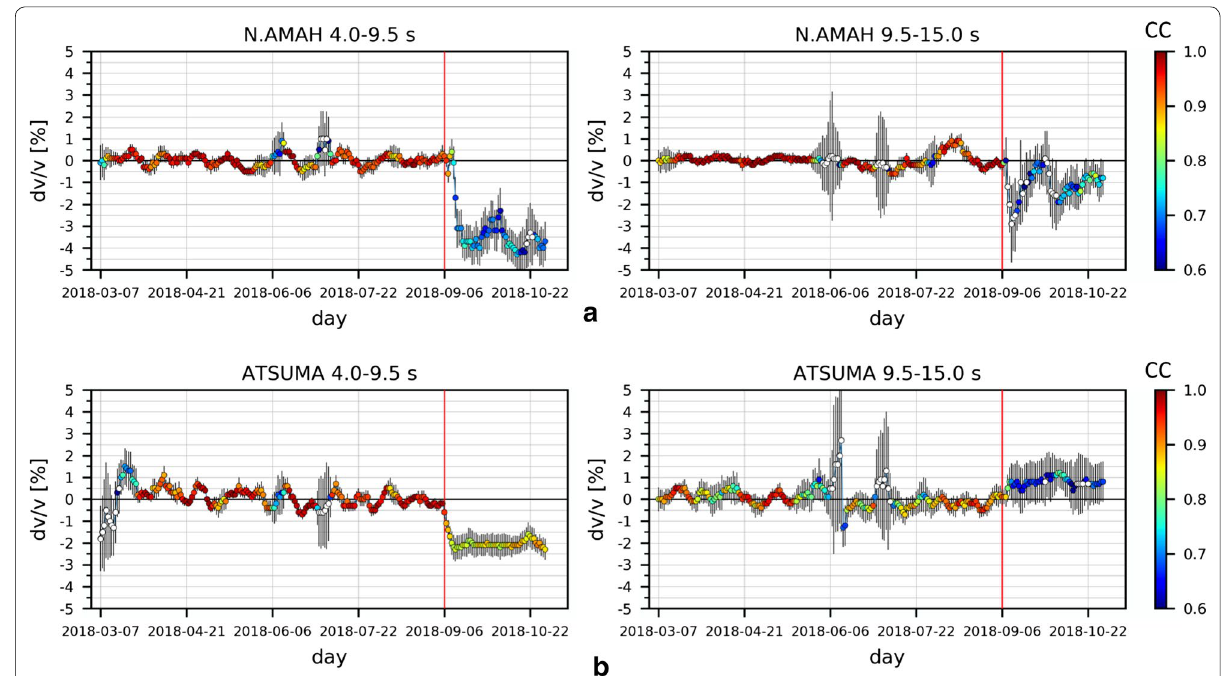
*Indicates we used unscreened data from KiK-net